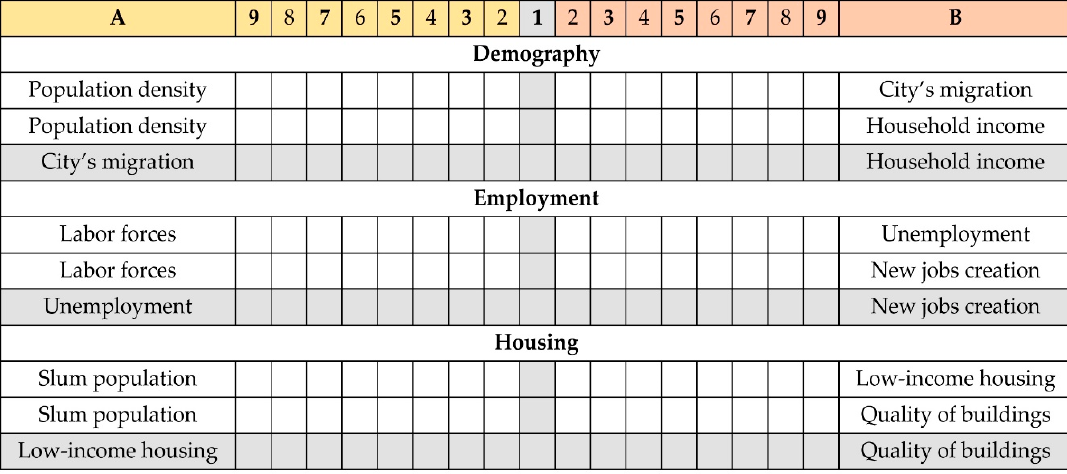
Figure A2. AHP questionnaire for prioritizing assessment indicators of Demography, Employment, and Housing. Note: 1 = Equal importance, 3 = Moderate importance, 5 = Strong importance, 7 = Very strong importance, 9 = Extreme importance (2,4,6,8- Values in-between). Question 2: Cont.